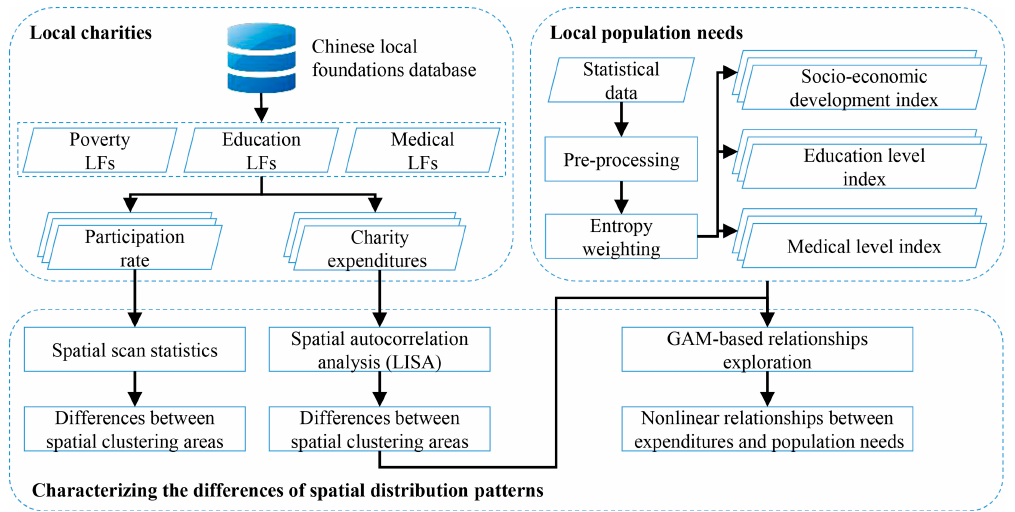
Figure 2. Schematic flowchart of the geospatial analysis for gaps between the distribution of local foundations and population needs.